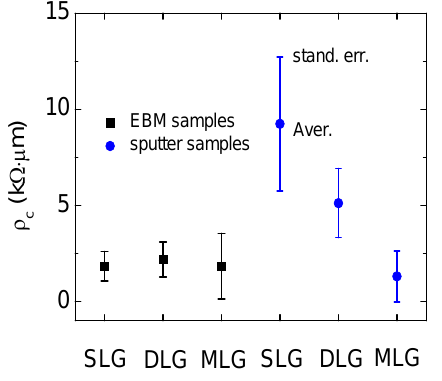
of Ti/SLG devices prepared by sputter processes at c increases more than two orders of magnitude c